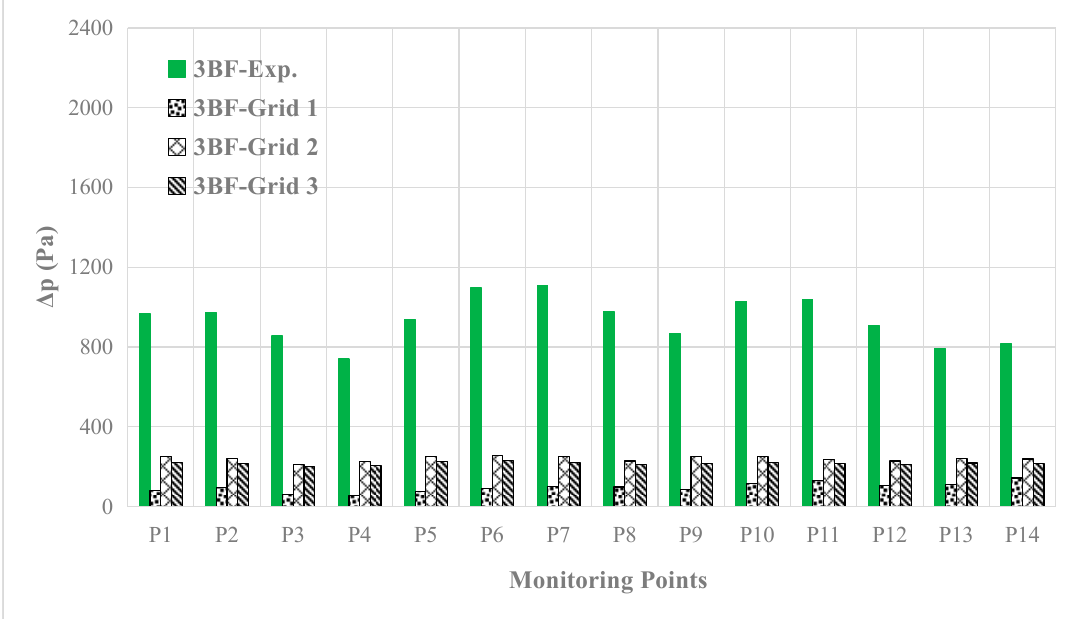
Figure 14. The 3BF component of hull pressure fluctuation predicted compared with the test data.